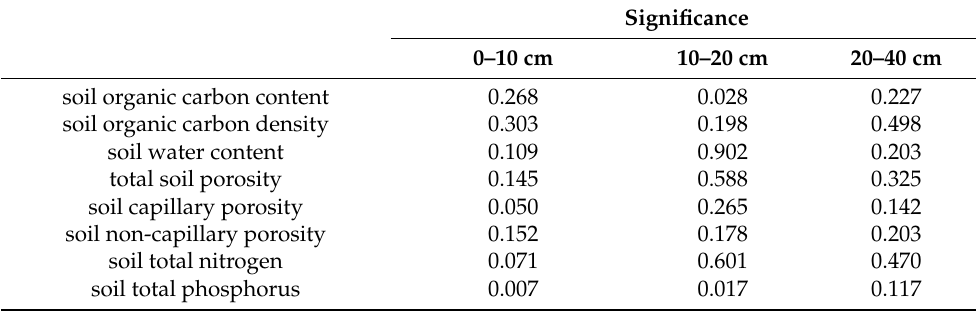
Table 2. Homogeneity test for variances.